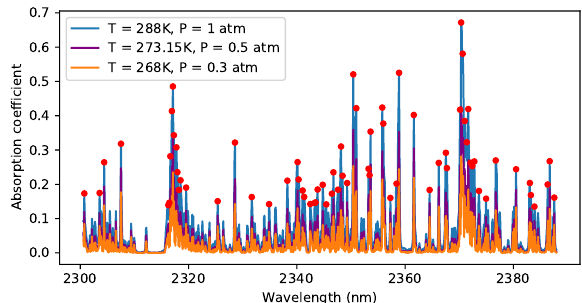
Figure 2. Comparison of methane absorption spectra under several pressure/temperature conditions. Red dots highlight the 70 maxima we use for detecting the